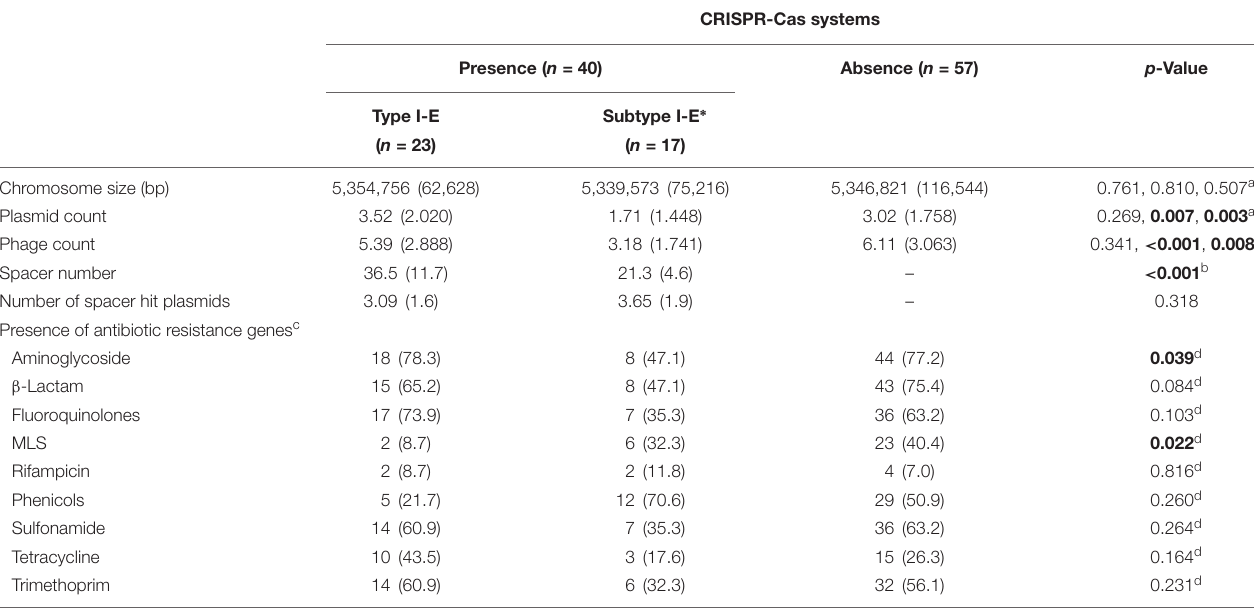
TABLE 1 | The association of CRISPR-Cas systems with chromosome size, plasmid count, phage count, spacer numbers, number of spacer hit plasmids, and the presence of antibiotic resistance genes among 97 K. pneumoniae